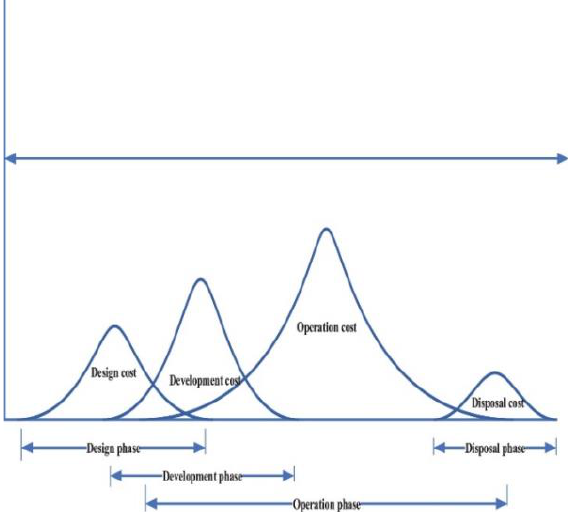
Figure 2: Aircraft Life Cycle Costs; Source: (Mofokeng et. Al.,